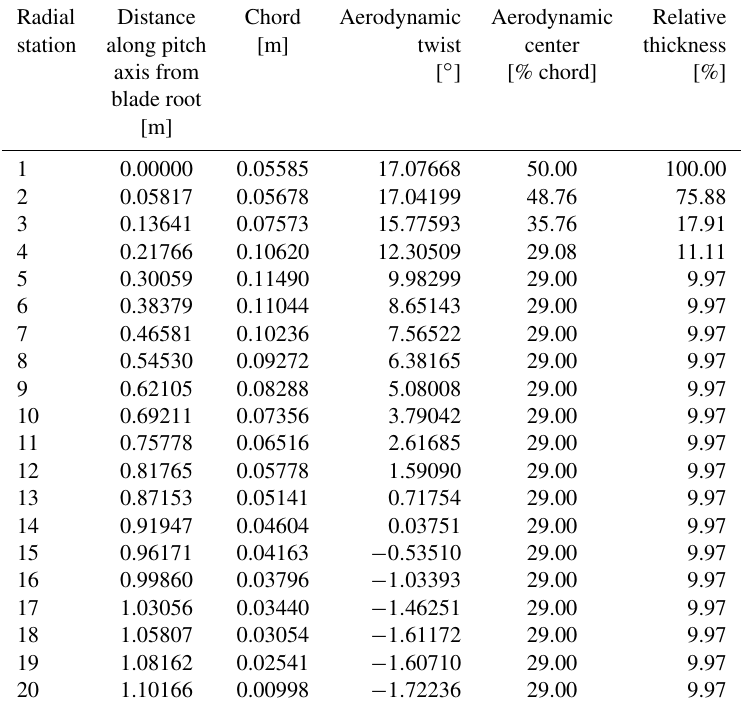
Table 1. Distributed blade properties.